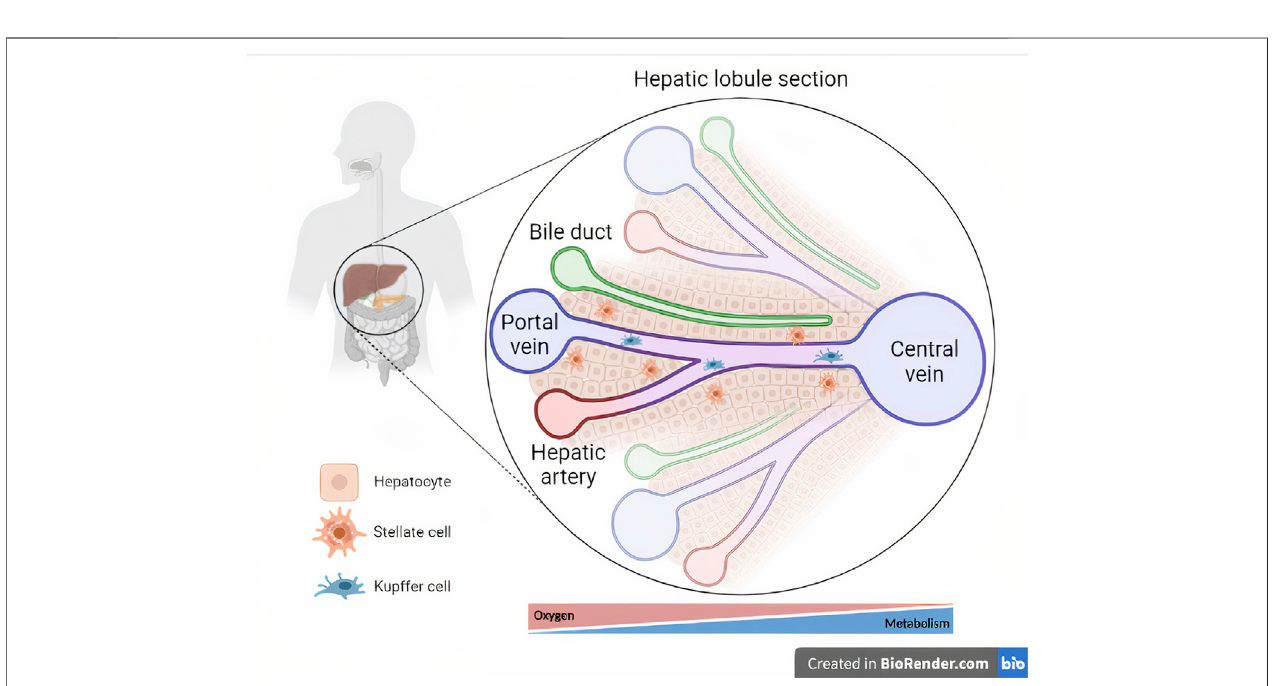
FIGURE2| Cellularcompositionandmicroarchitectureoftheliver.Thelivertissueismagni fi edwithinasectionofahepaticlobule,representingthecentralveinand its associated hepatic triads (i.e., bile duct, hepatic artery, and portal vein). Oxygen- and metabolism-driven zonation is represented below the hepatic lobule section (Created with